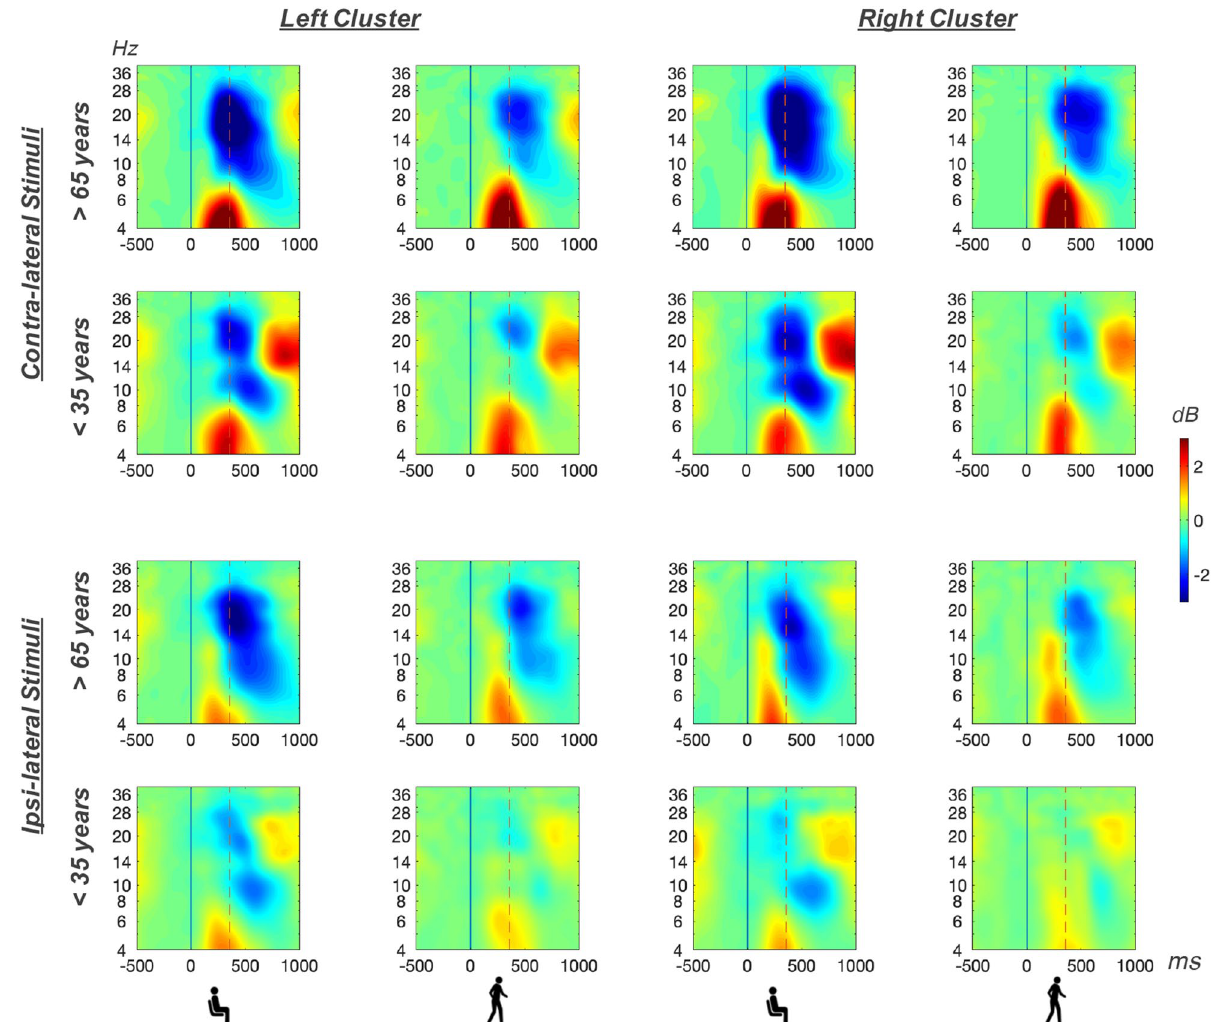
Figure 2. Mean ERSPs for the left centrolateral cluster (left two columns) and the right centrolateral cluster (right two columns) for contra-lateral presented stimuli (upper two rows) and ipsi-lateral presented stimuli (lower two rows), separately for older participants (fist and third row) and younger participants (second and fourth row) during sitting (first and third column) and walking (second and fourth column). ERSP trials were time-warped with respect to the stimulus onset (time point zero, solid line in black) and the mean button press response time (356ms after stimulus onset, dashed vertical line in ing) and the between factor age group (< 35 years, ≥ 70 years) was calculated for power values in this period. The main effect pattern matched the overall PSD pattern and we thus decided to only report and discuss the overall PSD values to avoid redundancy. Complete results can be found in the supplementary information (table S3). For the assessment of relative changes from single to dual-task conditions, proportional dual-task costs were calculated as proposed by Lindenberger et al. (2000) 26 : [(Single Task Score - Dual Task Score)/Single Task Score] *100. Distributions of the resulting ERSP dual-task cost data were found to be skewed and therefore transformed using ordered quantile normalization 27 prior to the statistical analysis. The transformed values follow a nor- mal distribution with highest positive values indicating highest dual-task costs (maximal observed reduction in desynchronization from sitting to walking) than positive values. Group differences in dual-task costs were assessed by Welch two-sample t-Tests. For the analysis of linear associations between ERSP estimates, visual task performance, and walking speed, partial correlations were calculated for the whole sample using partial Spearman rank correlations, control- ling for age, for absolute and dual-task cost measures. These measures were selected for the analysis of overall relationships in resource allocation processes for both parallel performed motor-tasks. In addition, confirma- tory correlations were calculated to control for further potentially mediating associations between button-press related ERSP values and several visual task measures (response times, misses as well as P1 and P3 amplitudes). The latter analyses were primarily executed to uncover if desynchronization levels are potentially driven by